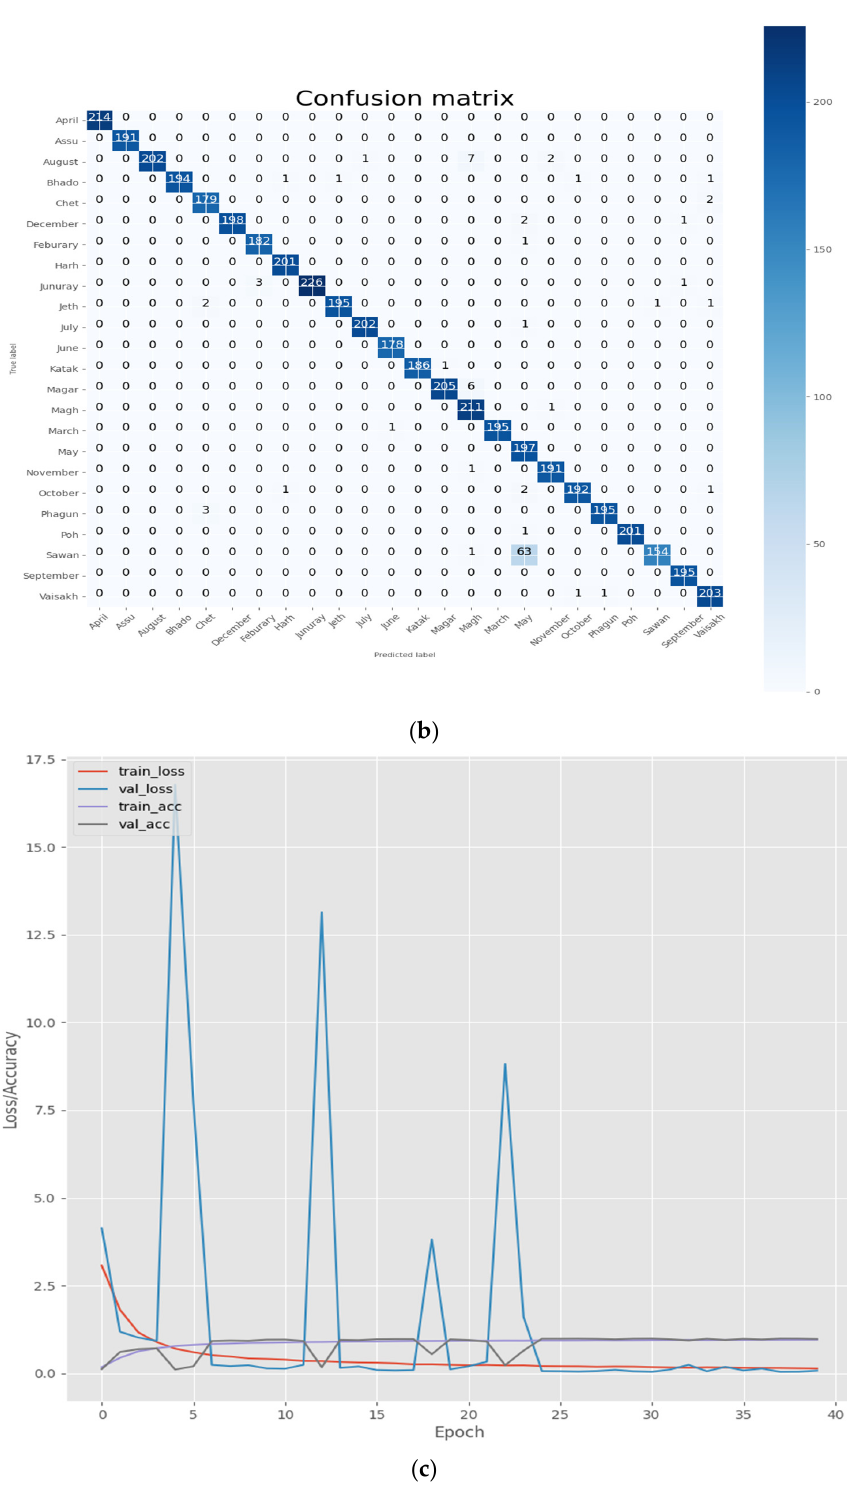
Figure 10. Analysis of proposed model at epochs 40 and batch size 30 ( a ) precision, recall and f1 score of 24 classes ( b ) confusion matrix ( c ) accuracy and loss curve.